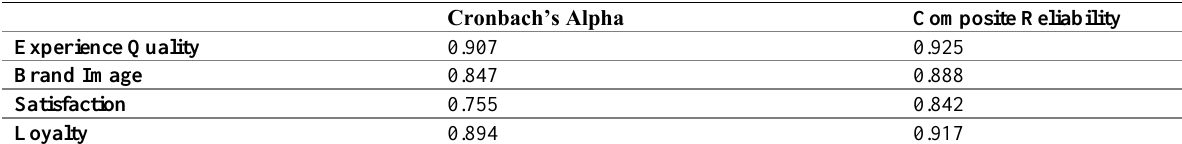
Table 5: Reliability